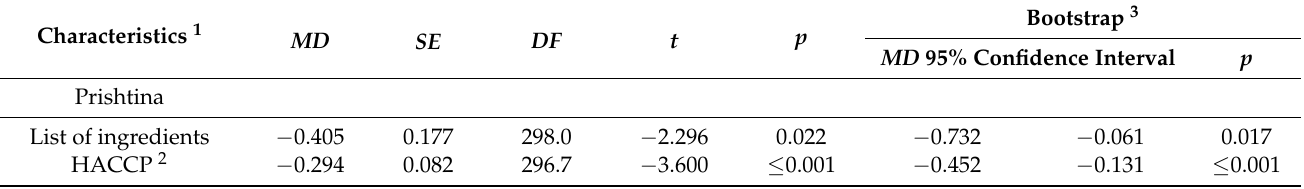
Table A1. Significant differences in the rating of food safety and quality cues with respect to the variable “gender”; samples: consumers from Kosovo (Prishtina; n = 299) and Albania (Tirana; n = 346); t -test including bootstrap sampling. Characteristics